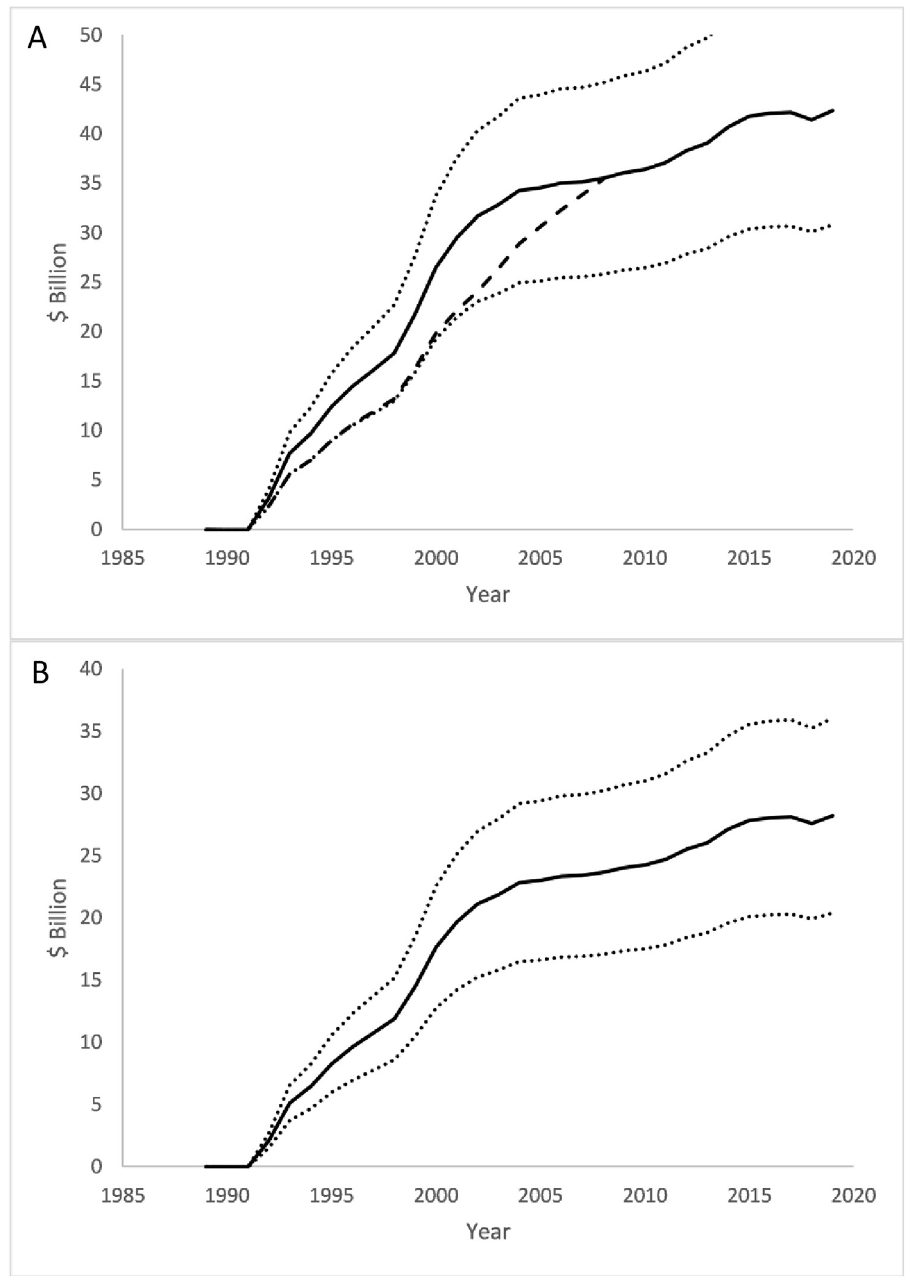
Fig 4. Annual total savings in real per capita healthcare expenditure attributable to the CTCP. (A) CMS measure. (B) NIPA measure. Black line: mean; Dotted lines: lower and upper 95% confidence intervals for prediction. Dashed black line in (A): estimated savings from ECTCP [4]. Note: vertical axes are real 2019 dollars.